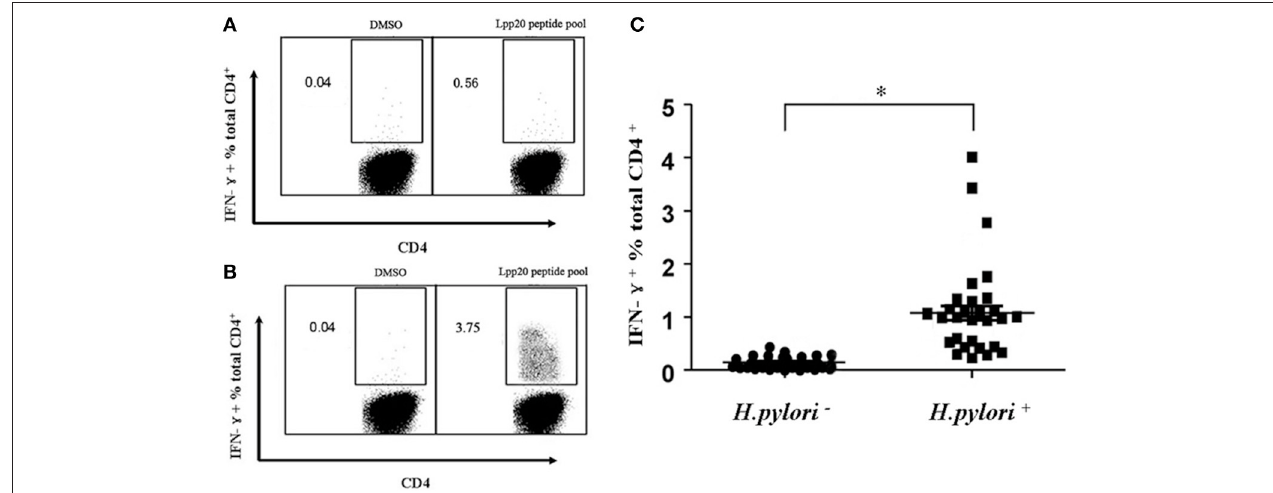
FIGURE 2 | Lpp20-specific CD4 + T cell responses in H. pylori -infected individuals. PBMCs from (A) H. pylori -uninfected subject N1 or (B) H. pylori -infected subject H1 were stimulated with recombinant Lpp20 and the percentage of IFN- γ producing antigen-specific CD4 + T cells were determined in an ICS assay using the Lpp20 peptide pool on day 13. DMSO was used as a control. (C) PBMCs from 30 H. pylori infection-negative (–) and 30 H. pylori infection-positive ( + ) subjects were stimulated with recombinant Lpp20 and the percentage of IFN- γ producing CD4 + T cells were assessed as previously mentioned. * p <